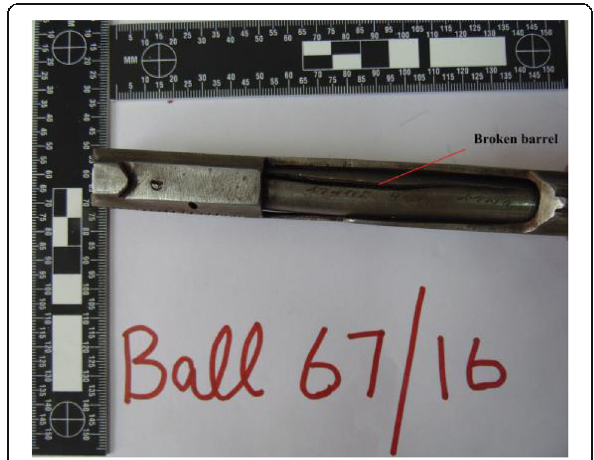
Fig. 2 Showing broken barrel of country made pistol